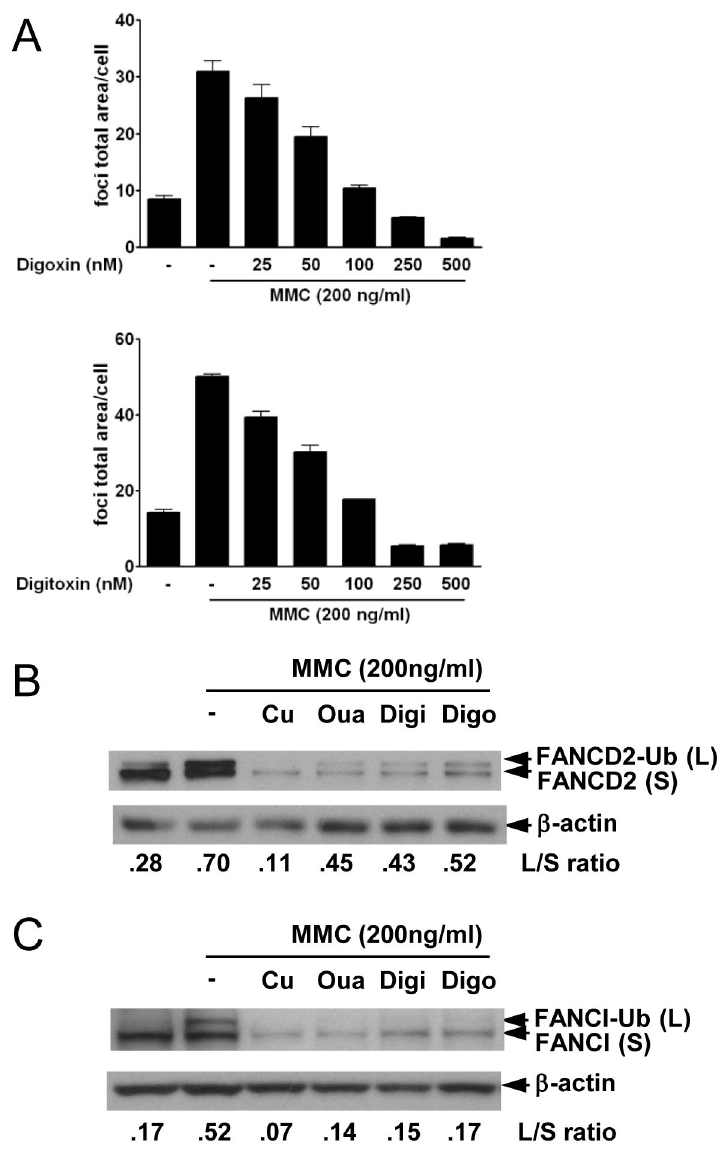
Figure 2. Cardiac glycoside family members inhibit the FA/BRCA pathway. (A) U2OS cells were pretreated with the indicated concentration of digitoxin or digoxin for 1 h and then incubated in 200 ng/ml MMC for 24 h. After incubation, the cells were fixed and processed for FANCD2 immunofluorescence and the FANCD2 foci were analyzed with IN Cell Analyzer. Representative graphs from three independent experiments are shown. Values represent the means ± SEM.(B) (C) Protein extracts from U2OS cells pretreated with 5 µM curcumin, 100 nM ouabain, 100 nM digitoxin and 100 nM digoxin and incubated in 200 ng/ml MMC for 24 h as described in (A) were analyzed by Western blotting using antibodies against (B) FANCD2, (C) FANCI, and β-actin. L/S values shown represent the ratio of FANCD2 (L)/FANCD2 (S) or FANCI (L)/FANCI (S). doi: